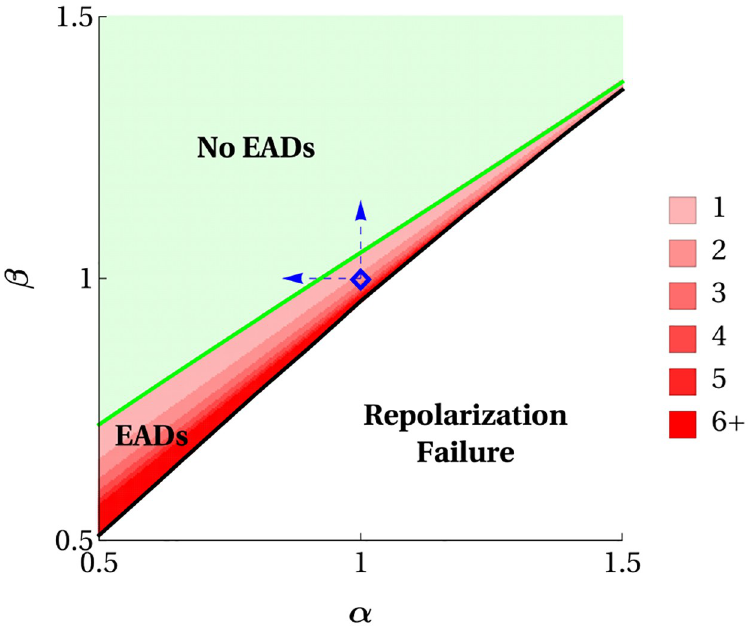
Fig 12. Model responses to variation in scaling parameters of Ca 2+ channel activation ( α ) and inactivation ( β ) timescales under simulated hypokalemia. The blue � marker denotes the hypokalemia condition of Fig 10 and the blue dashed arrows highlight two separate dynamic clamp manipulations predicted to eliminate hypokalemia-induced EADs.